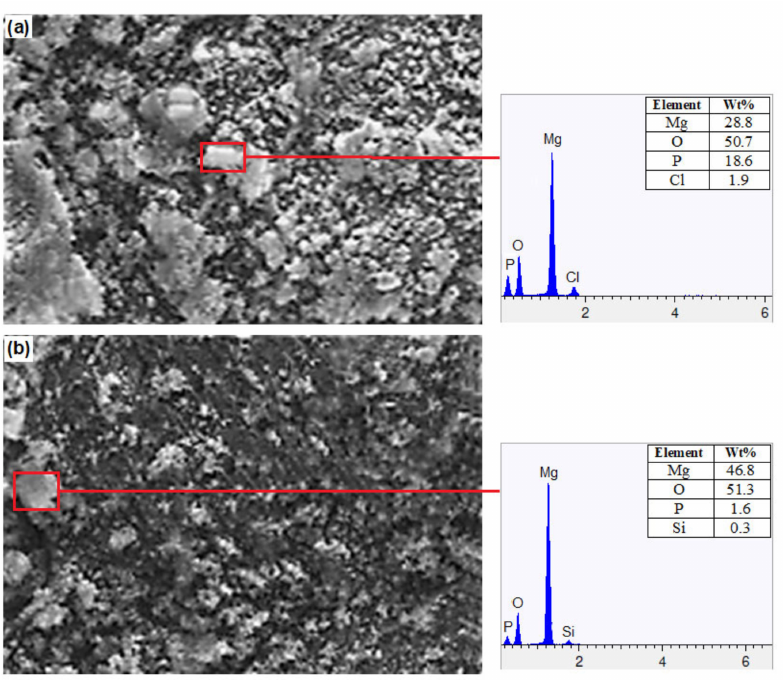
Figure 9. EDX analysis of the corroded samples ( a ) Mg Alloy, ( b ) Mg + 3% SiO 2